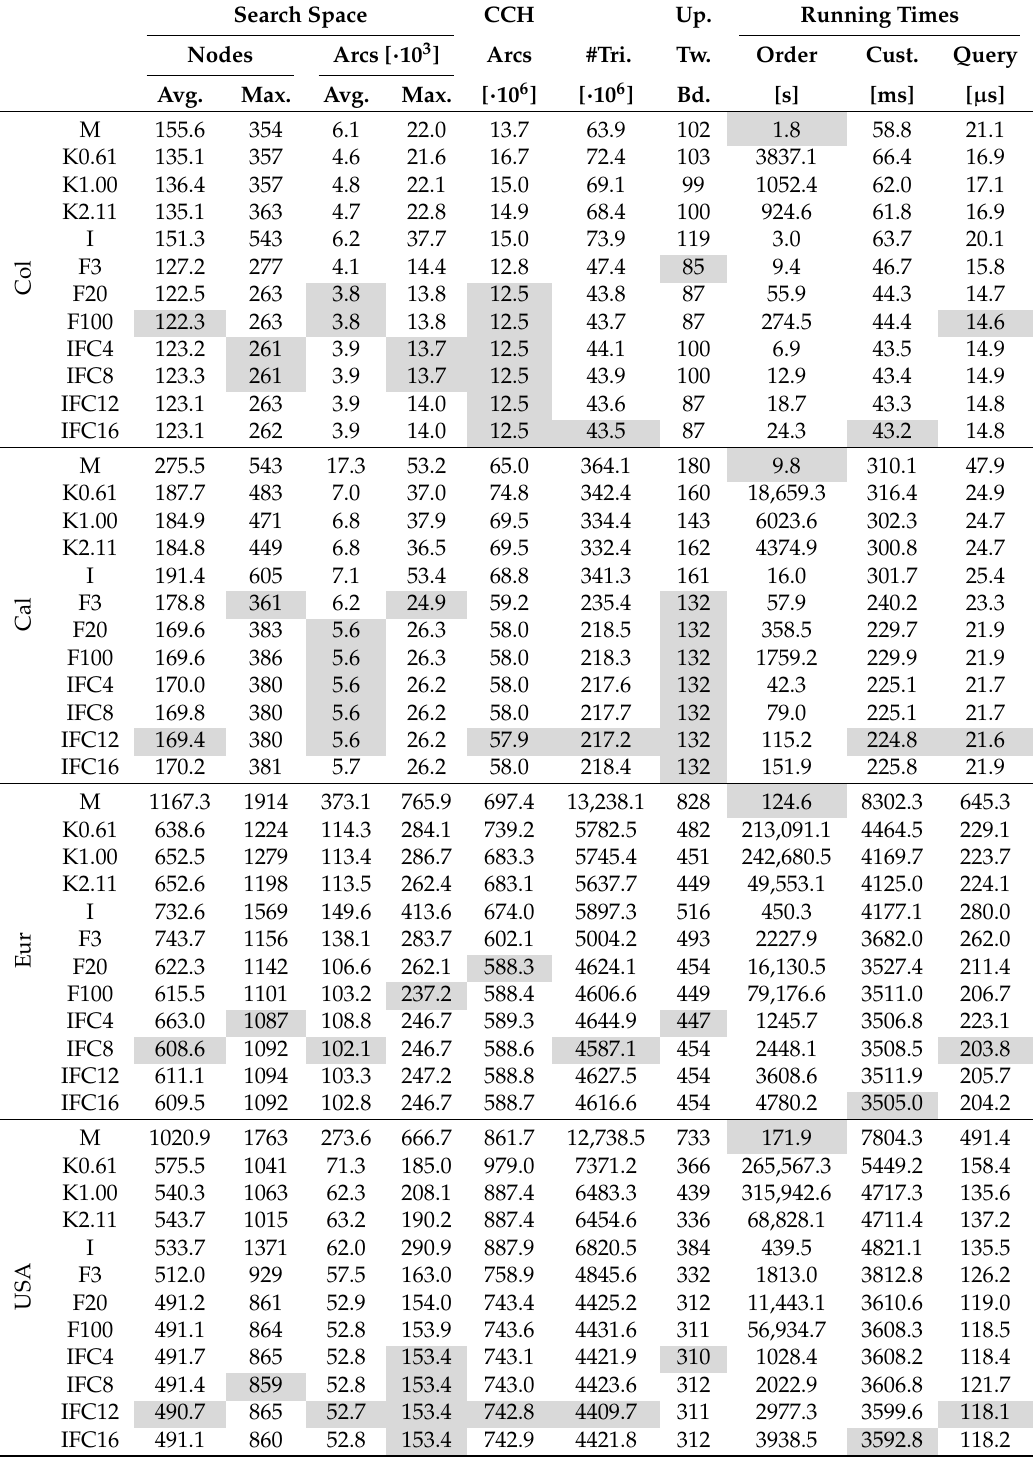
Table 2. Customizable Contraction Hierarchy (CCH) order experiments. The best values (smallest) per metric and graph are